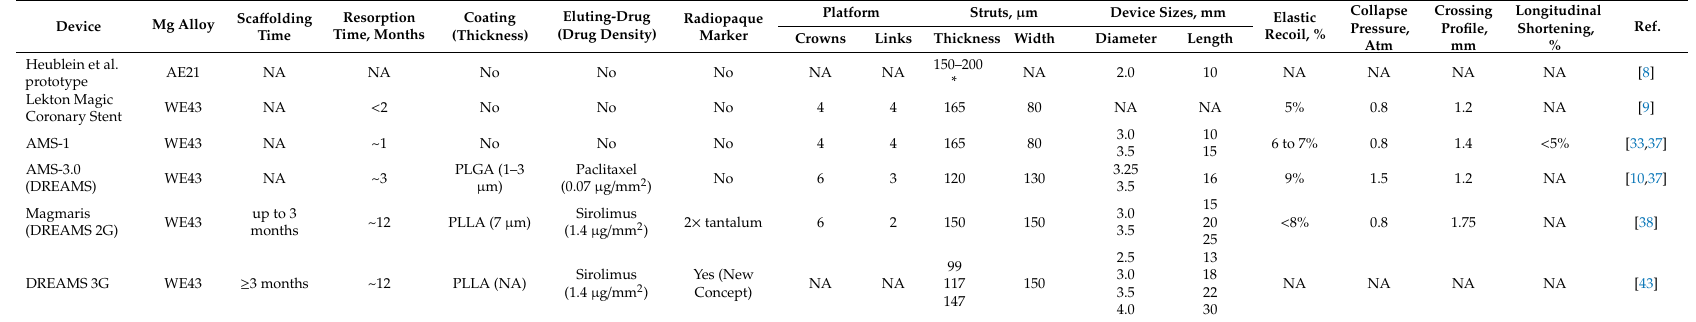
Table 1. Magnesium-based bioresorbable sca ff olds